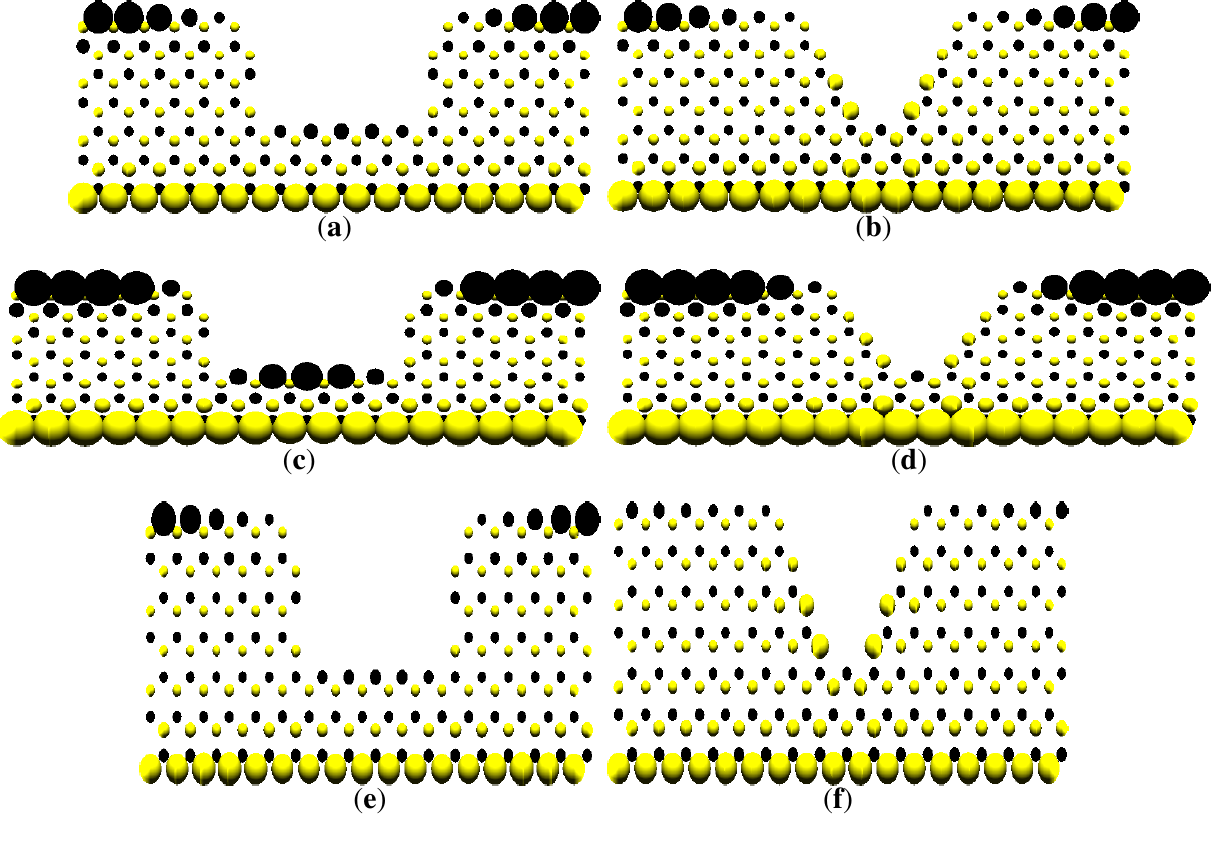
Figure 3. (Color on-line). Local spin-polarization for a zero-strained ZGNR device with a ( a ) square notch, and ( b ) V-shaped notch. 20% (maximum) x -strained ( c ) square, and ( d ) V- shaped notched ZGNRs, and 20% (maximum) y -strained ( e ) square notch, and ( f ) V-shaped notched ZGNRs. Yellow (black) refers to spin-up (down), with the magnitude of the spin- polarization (Equation 3) being indicated by the circle radius. N.b., the local spin-polarization on the atoms that are directly coupled to the leads, is equal to that of an ideal (unstrained or strained)